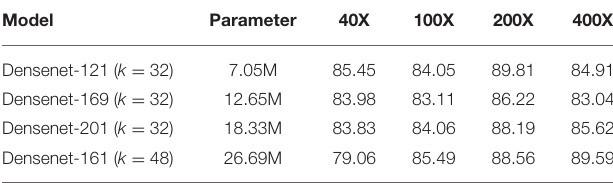
TABLE 1 | Accuracy rate with four typical DenseNet-BC